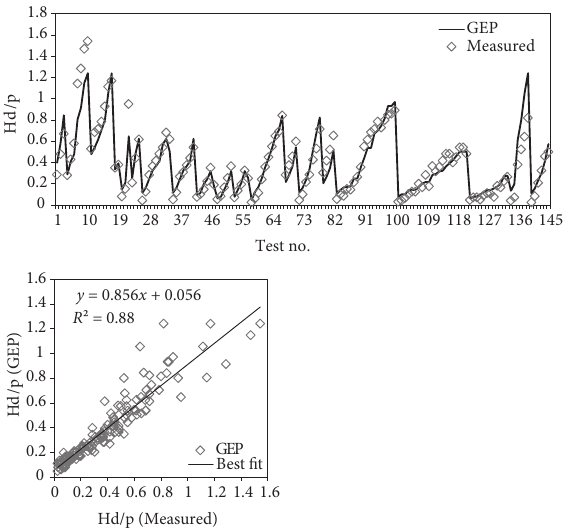
/P versus measured ones for train Fig. 7. GEP estimations of H d